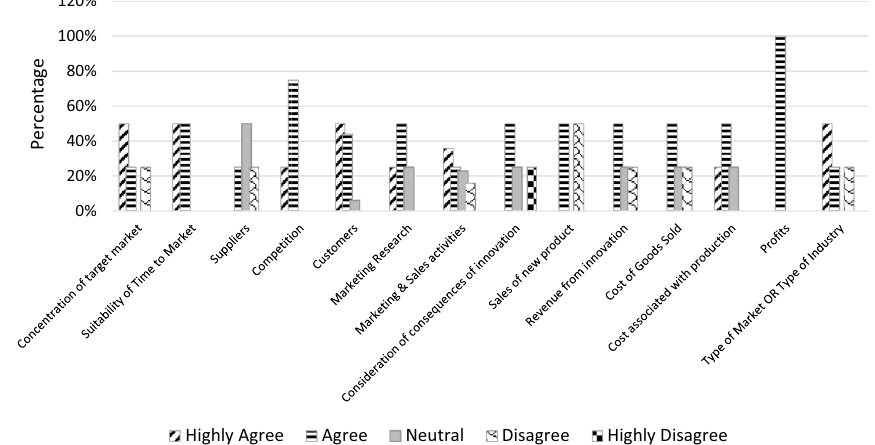
Fig. 8 Survey results related to market factors